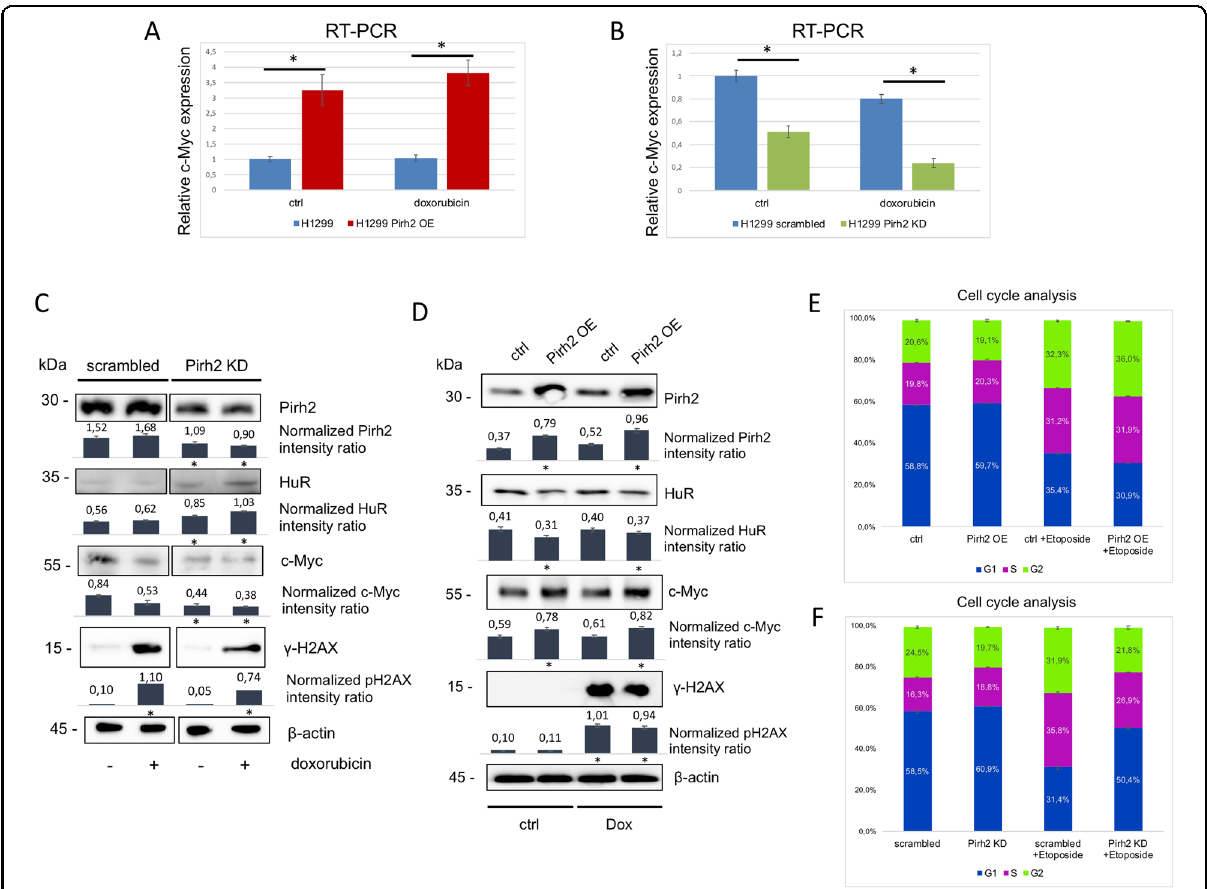
Fig. 5 Pirh2 activates c-Myc expression via downregulation of HuR. A Pirh2 upregulates c-Myc mRNA level in H1299 cells. qRT-PCR results of c- Myc expression for H1299 cells with stable Pirh2 overexpression (Pirh2 OE) and control H1299 cells (ctrl), both in normal conditions and after 16 h treatment with 1 μ M doxorubicin. * p ≤ 0.01 according to Student ’ s t -test. B Pirh2 knockdown leads to a decrease of c-Myc mRNA level. qRT-PCR results of c-Myc expression for H1299 cells with stable Pirh2 knockdown (Pirh2 KD) and control H1299 cells (scrambled), both in normal conditions and after 16 h treatment with 1 μ M doxorubicin. * p ≤ 0.01 according to Student ’ s t -test. C Pirh2 upregulates c-Myc protein level in H1299 cells. Western blot analysis of c-Myc protein level for H1299 cells with stable Pirh2 overexpression (Pirh2 OE) and control H1299 cells (ctrl), both in normal conditions and after 16 h treatment with 1 μ M doxorubicin. D Pirh2 knockdown leads to a decrease of c-Myc protein level. Western blot analysis of c- Myc level in H1299 cells with stable Pirh2 knockdown (Pirh2 KD) and control H1299 cells (scrambled), both in normal conditions and after 16 h treatment with 1 μ M doxorubicin. The normalized intensity ratios were calculated as ratios between the signals of proteins analyzed and the corresponding actin bands on the basis of three measurements. Error bars indicate ±SD. * p ≤ 0.05 vs. scrambled (vs. untreated for γ H2AX) according to Student ’ s t -test. E , F Analysis of cell cycle phases distribution for H1299 cell lines with stable Pirh2 overexpression (Pirh2 OE) and control H1299 (ctrl) (left panel), and H1299 cells with stable Pirh2 knockdown (Pirh2 KD) and control H1299 cells (scrambled) (right panel), both in normal conditions and after 24 h treatment with 100 μ M etoposide. The test was performed in triplicates. Error bars indicate ±SD. * p -value ≤ 0.01 according to Student ’ s t